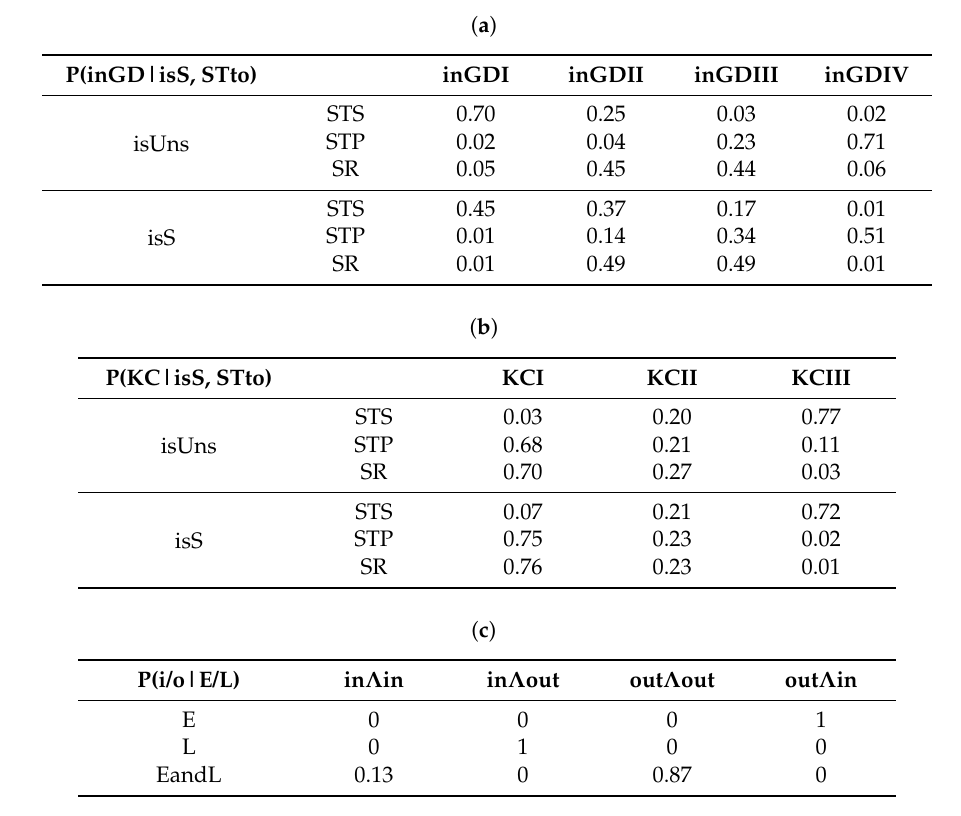
Table 3. Conditional probability in time slice of